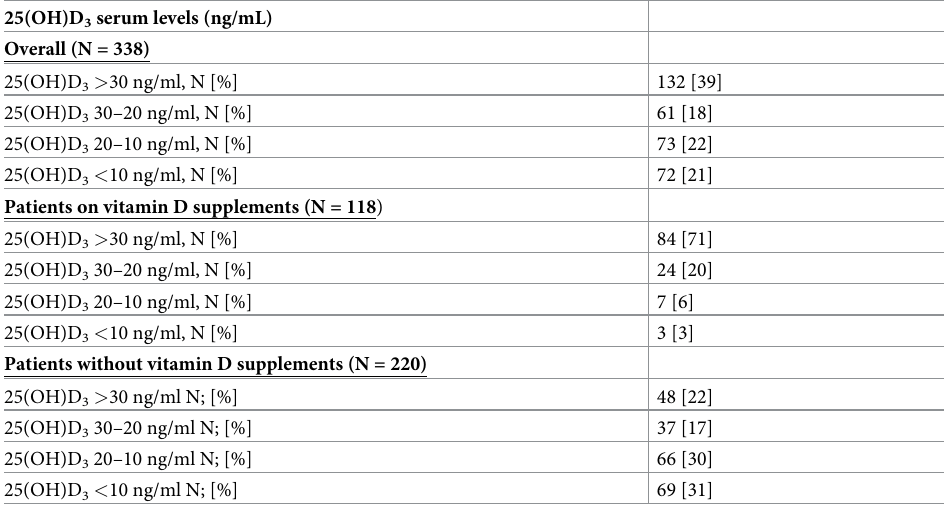
Table 2. 25(OH)D3 serum levels in patients with advanced liver